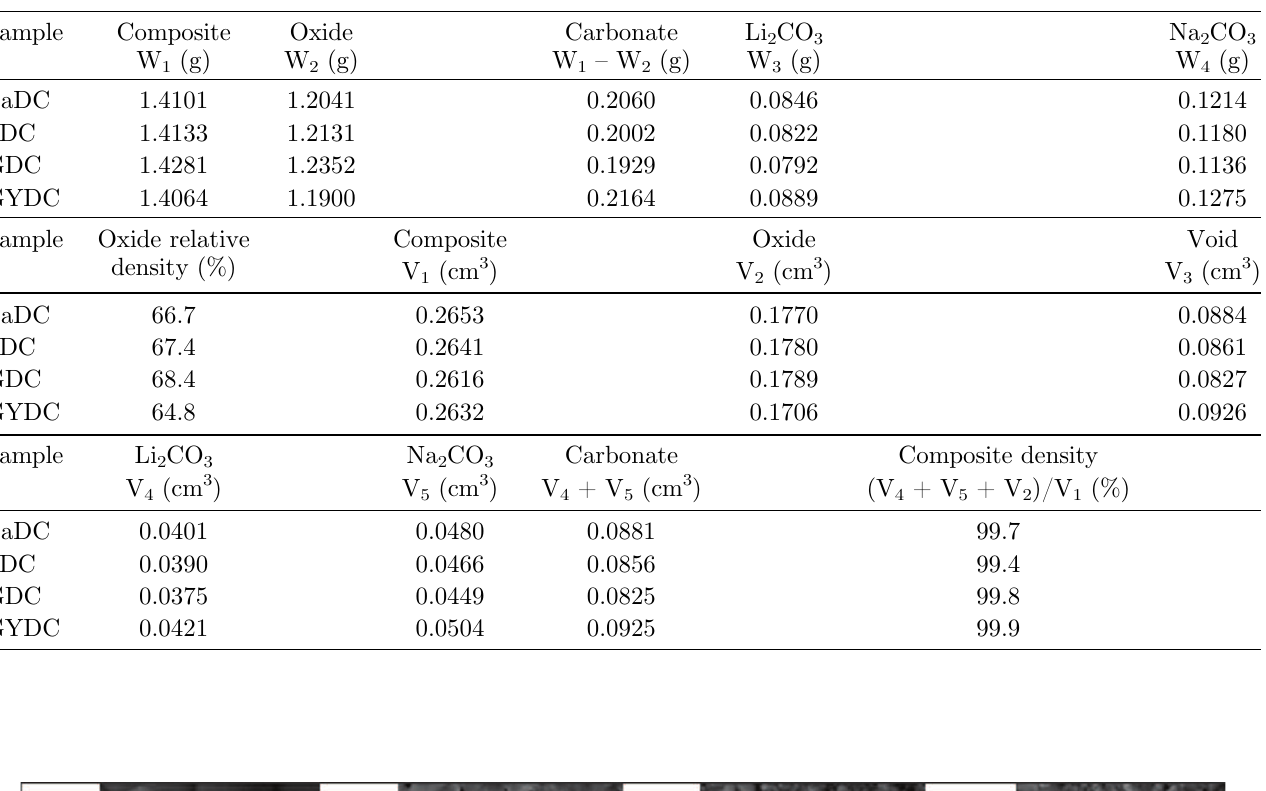
Table 4. Carbonate composite density calculation process and